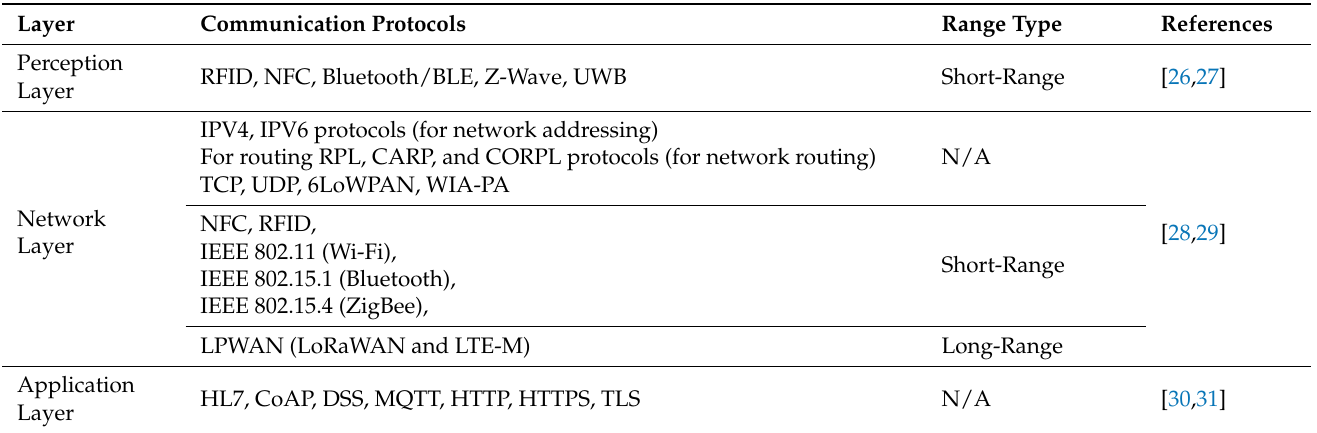
Table 2. The primary protocols used in IoMT systems at various